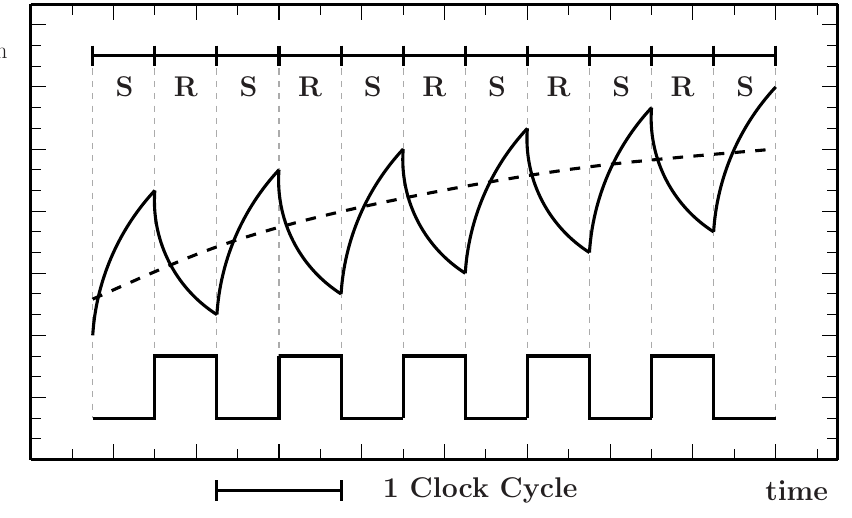
Figure 1. Illustration of Dynamic BTI. Each clock cycle consists of two phases: (1) Stress (D) and (2) Recovery (R). The dashed line represents the overall aging process, i.e. , the increasing trend of V th